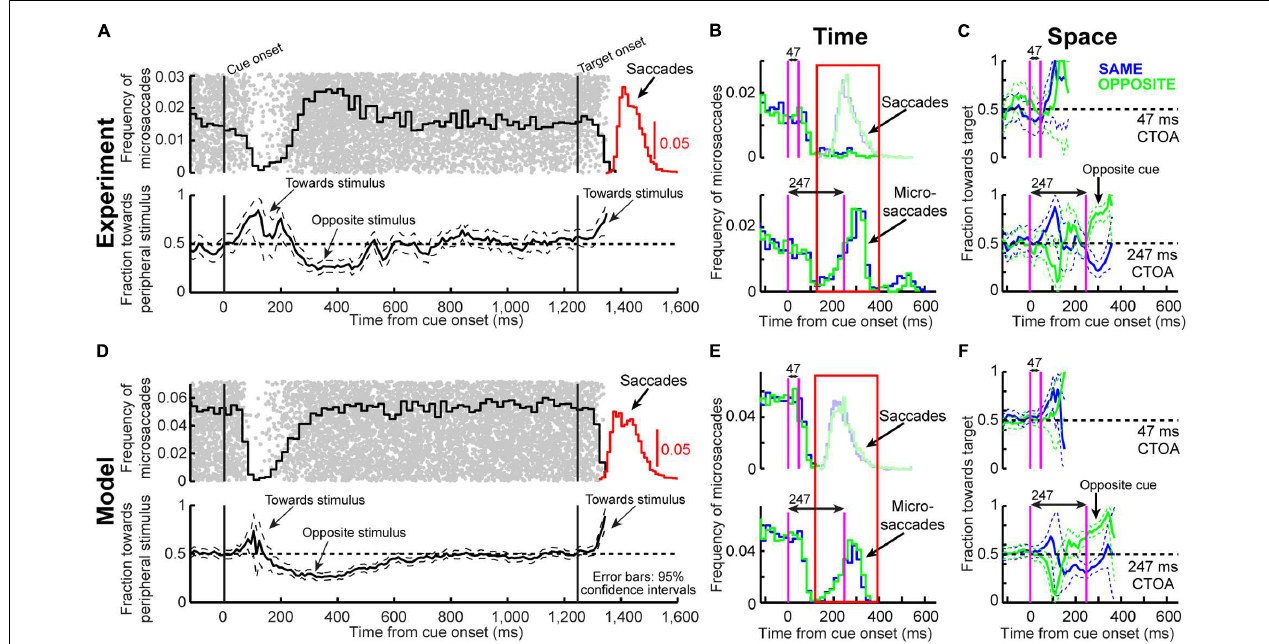
FIGURE 4 | Microsaccade dynamics in the cueing task (experiment and model). (A) Microsaccade frequency (top) and direction (bottom) as a function of time for 1,247 ms CTOA’s ( > 4,000 trials). Top plots the fraction of trials containing microsaccades. Bottom plots the fraction of microsaccades directed toward the peripheral stimulus. Red indicates RT for large saccades (note specific scale bar). Microsaccades exhibited well-known modulations. Gray dots are rasters of microsaccade onset times across trials. (B) Microsaccade frequency in two CTOA’s (top and bottom). Colors refer to the location of the target relative to the cue (blue for “same”). The faint histograms show saccade RT’s with similar color coding. Longer CTOA’s (bottom) exhibited microsaccades at the time at which large saccades would have occurred if fixation was not enforced (compare to the saccade RT’s in the short CTOA’s – red rectangle). Magenta lines indicate cue/target onset. (C) Microsaccade directions in the CTOA’s of (B) . When there was sufficient time between cue and target, microsaccades were initially biased toward the cue (thus opposite the target for the green curves in which the cue was opposite the target location). For 247 ms, most microsaccades near target onset were toward the target in the opposite condition because they had flipped from being toward the cue earlier. (D–F) Model simulations from the scheme of Figure 2 capturing all the salient features of the data. All error bars denote 95% confidence intervals. Each experimental condition has N ∼ 2,000–3,000 trials; simulations: 2,000